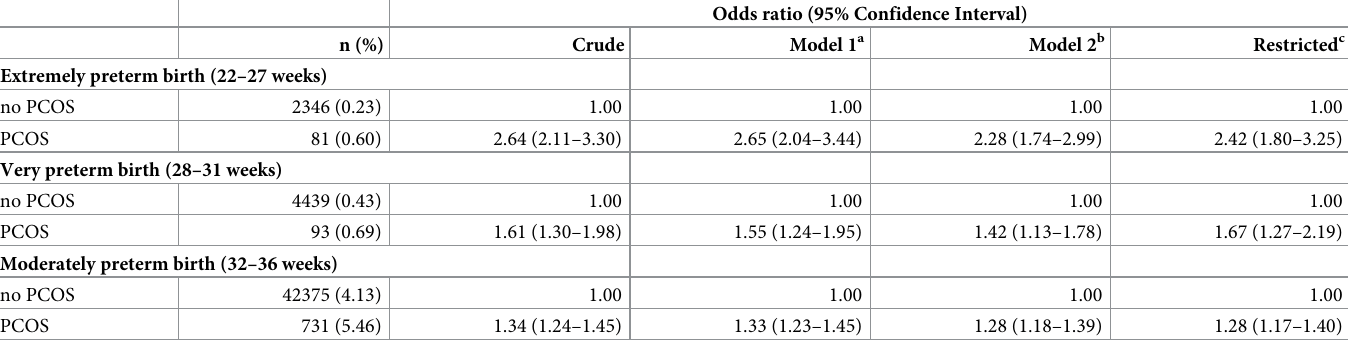
Table 3. Risk of preterm birth, according to severity and PCOS diagnosis, in women giving birth in Sweden 2005–2014.